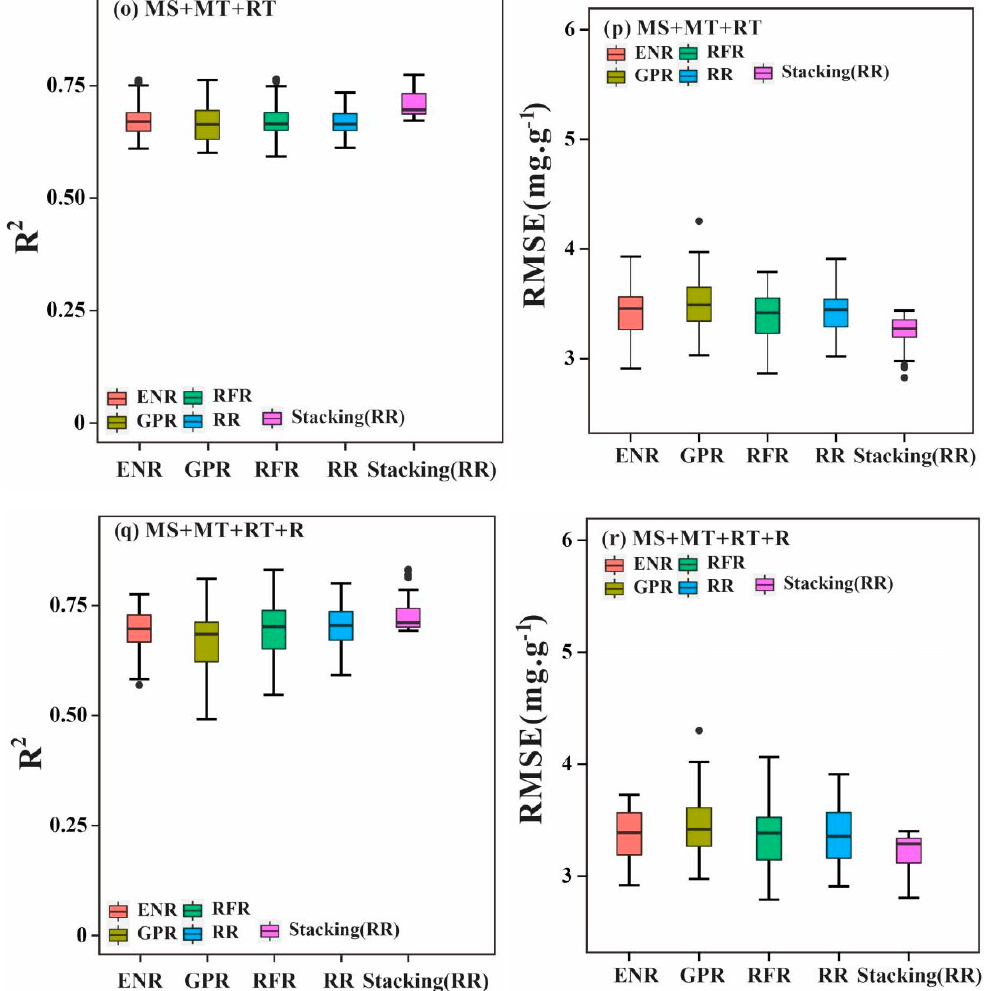
Figure 5. Statistical distribution of the prediction accuracy of individual machine learning models and ensemble learning models constructed based on spectral and texture features of UAV RGB and multispectral. RT RGB Texture Features, MS Multi-spectral spectral features, MT Multi-spectral texture features, ENR Elastic network regression, RFR Random Forest regression, GPR Gaussian process regression, RR Ridge Regression, Stacking (RR) stacking regression using ridge regression as a secondary learning model.